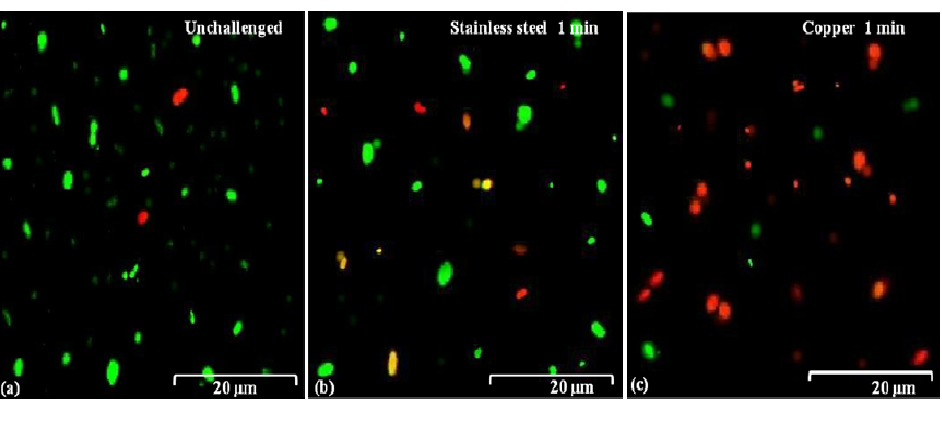
Figure 5. Membrane damage of B. glumae cells exposed to copper surfaces for 60